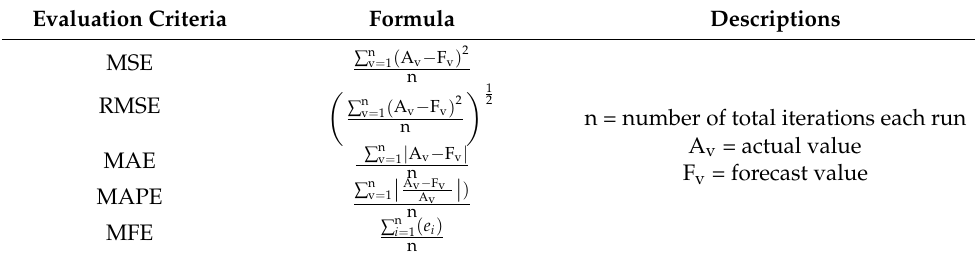
Table 5. The Computational Measures’ Formula.